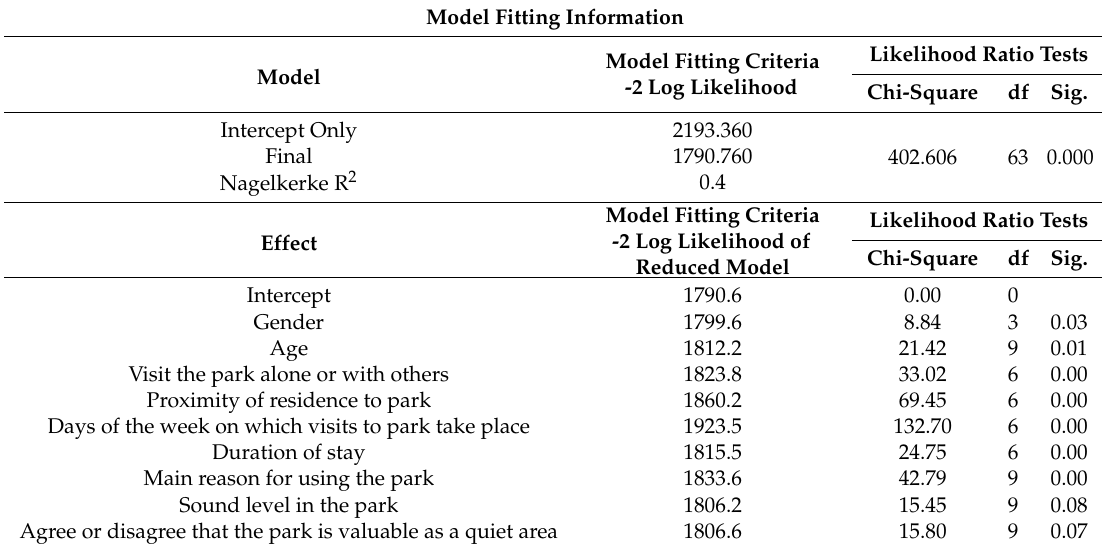
Table 2. Model fitting information and statistical significance of the independent